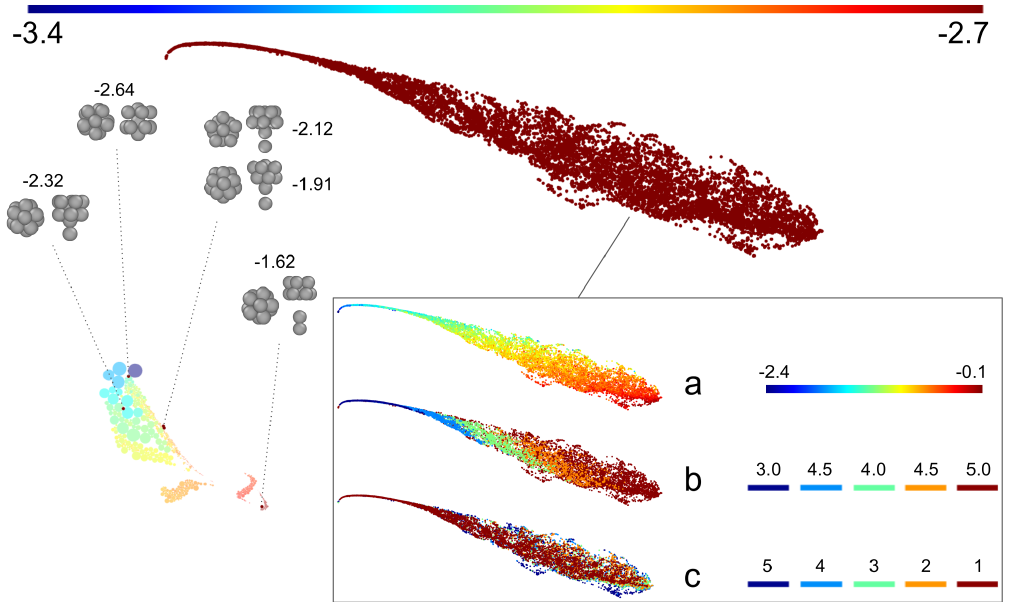
FIG. 4. 2D SHEAP map constructed from a dataset of minima and unrelaxed structures on the LJ 13 PES, described by sorted lists of all pairwise distances. The projection uses a perplexity of 8. Circles in the main figure are colored according to energy per atom in Lennard- Jones units, given by the color bar at the top of the figure. Minima (all in the bottom-left cluster) are faded, with basin volumes represented by the area of each circle, using a minimum sphere radius R 0 ¼ 0 . 005 . Circles representing unrelaxed structures are enlarged to highlight them. The figure inset provides different colorations of the top cluster, which contains only unrelaxed structures. Coloring is according to (a) energy per atom in Lennard-Jones units, (b) the confinement radius in Lennard-Jones units, and (c) the number of imposed symmetry operations — see corresponding color bars to the right of the inset. The few unrelaxed structures that cluster with the minima (all possessing five symmetry operations) are labeled with their energy per atom in Lennard-Jones units, alongside two perpendicular perspectives of their configuration.